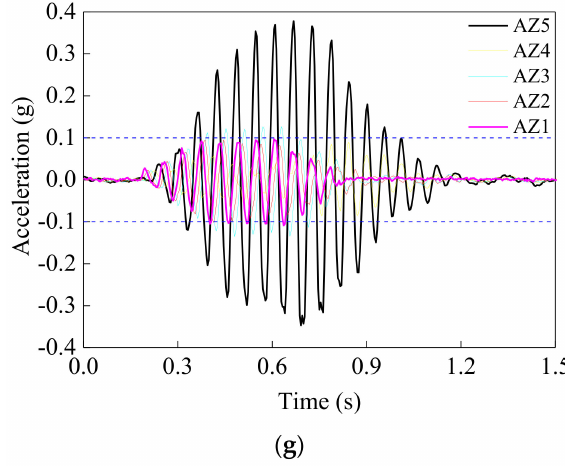
Figure 12. Acceleration responses with depths in FF model. ( a ) Sin-2. ( b ) Sin-3. ( c ) Sin-6. ( d ) Sin-9. ( e ) Sin-11. ( f ) Sin-14. ( g ) Sin-17.